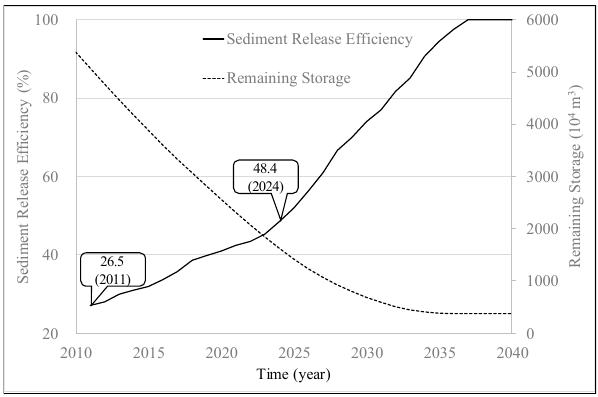
Figure 9. Annual sediment release efficiency and remaining storage of the Wushe Reservoir.